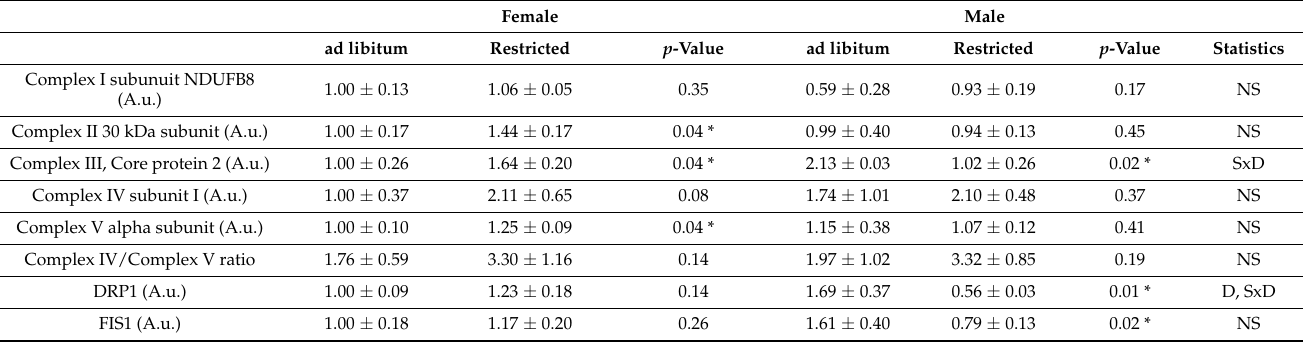
Table 2. Protein levels of OXPHOS complexes and mitochondrial fission proteins analyzed by Western Blot. Two-way ANOVA was performed to assess for significance. Abbreviations: S, sex differences; D, diet differences; N, non-significant. * Statistical differences between calorie restricted and control